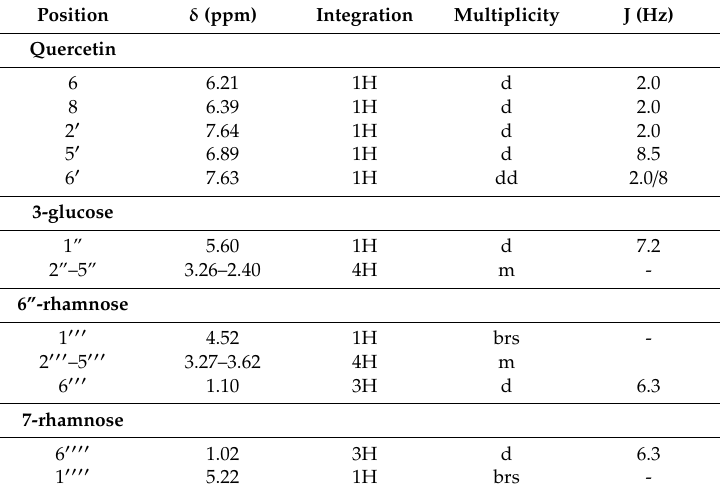
Table A1. 1 H-NMR spectra data of quercetin-3-rutinoside-7-rhamnoside (CD 3 OD). Position δ (ppm)